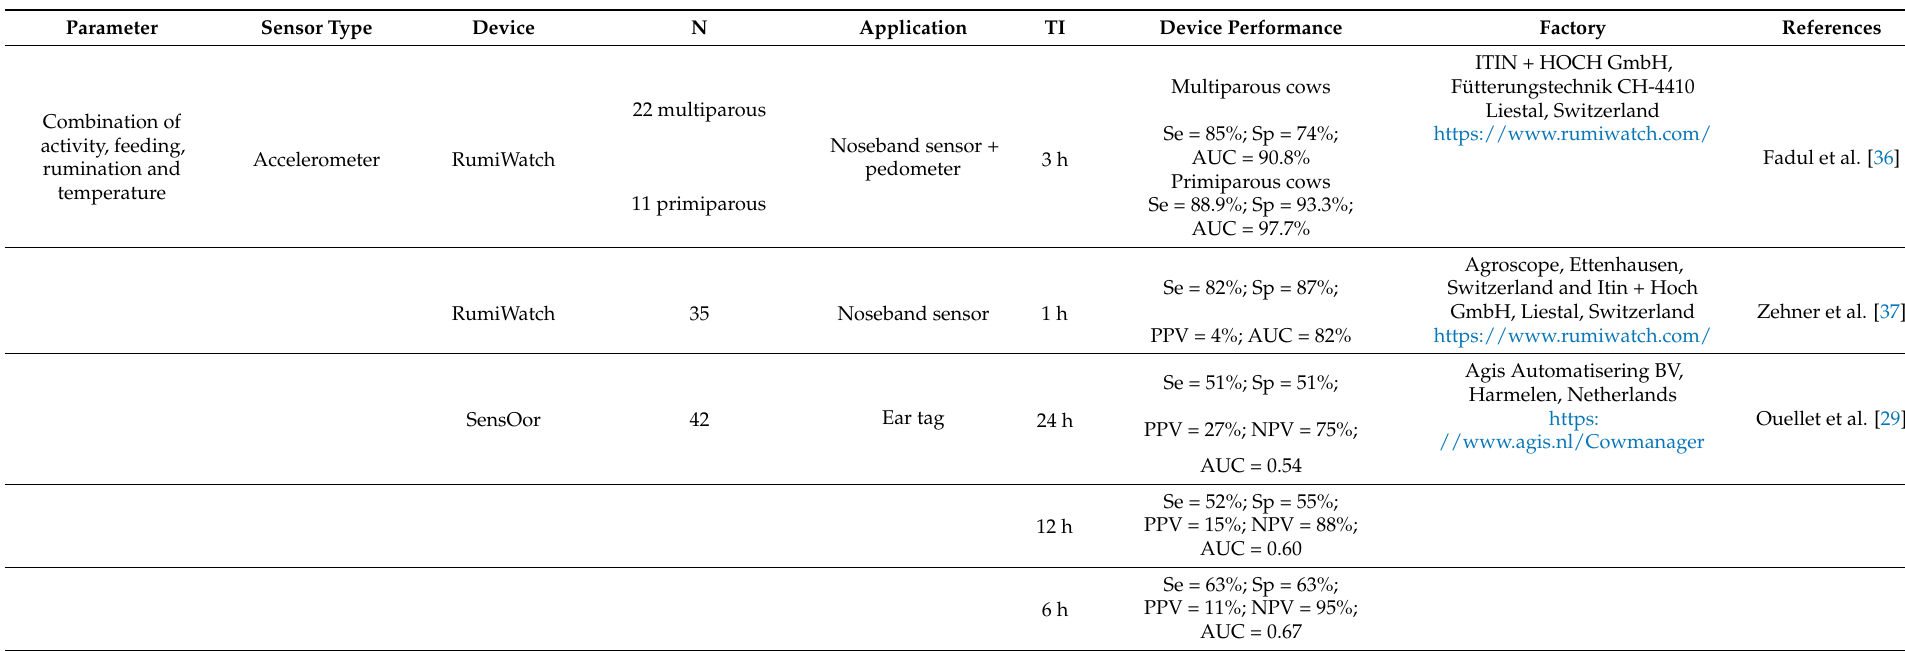
Table 2. Devices for automatic combined activity and feeding monitoring for calving prediction, with performance and